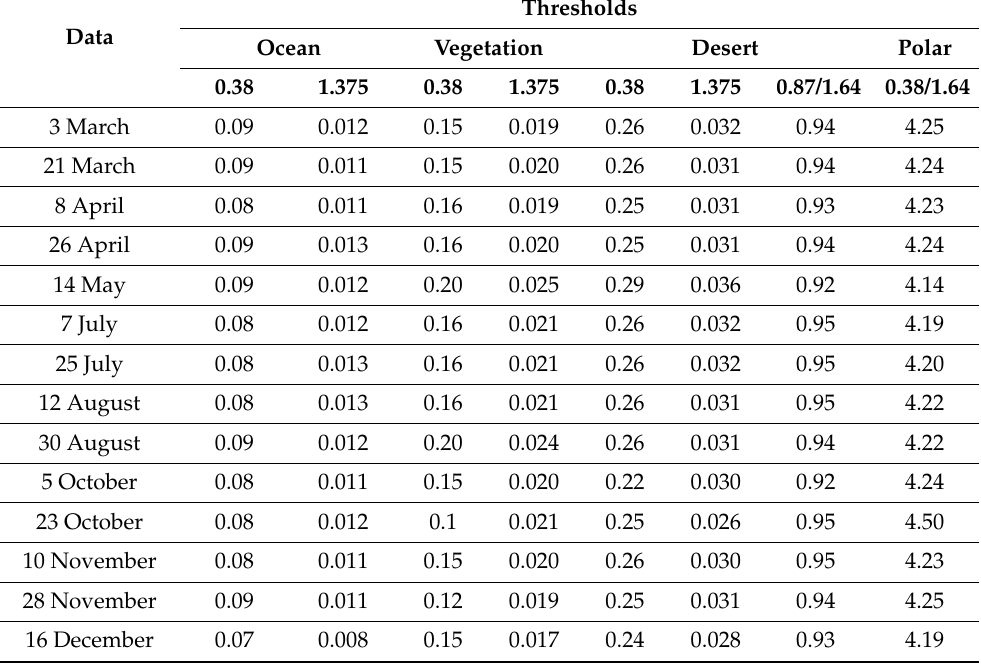
Table 4. The statistical results of cloud detection thresholds every 18 days from March to December 2017 for the representative regions of four land surface